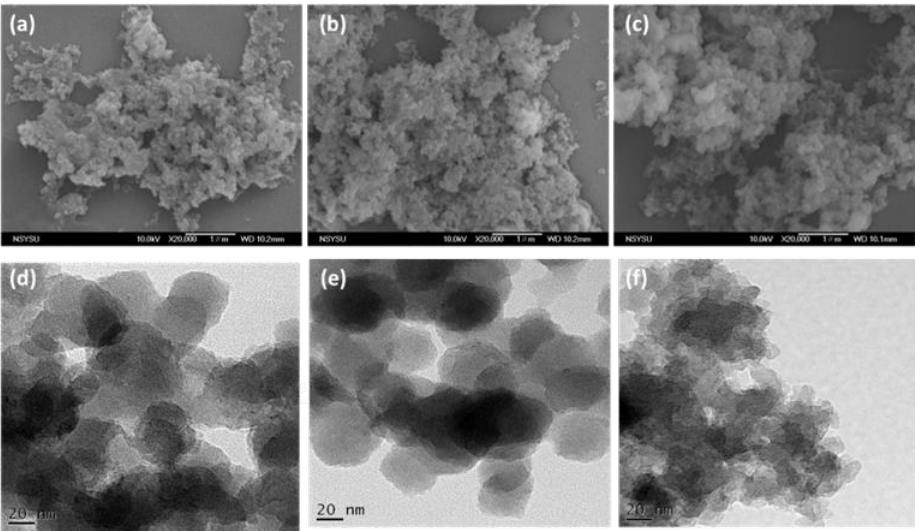
Figure 5. ( a – c ) SEM and ( d – f ) TEM images of the ( a , d ) POSS-OXD, ( b , e ) POSS-Th, and ( c , f ) POSS- TPTh POIPs.